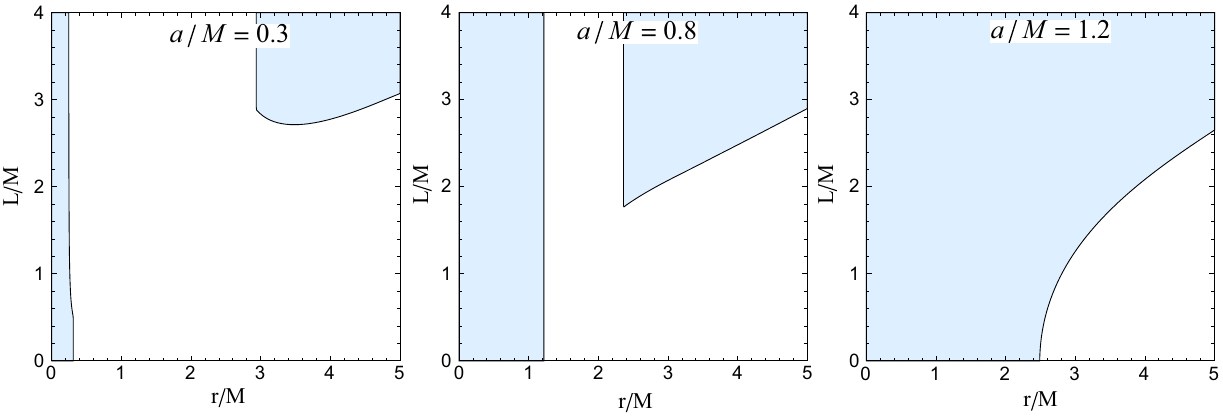
Fig. 4 Plot showing the regions where the NEC is satisfied ( shaded regions ) at the poles of the non-singular rotating black hole spacetime in conformal gravity. Here N = 1